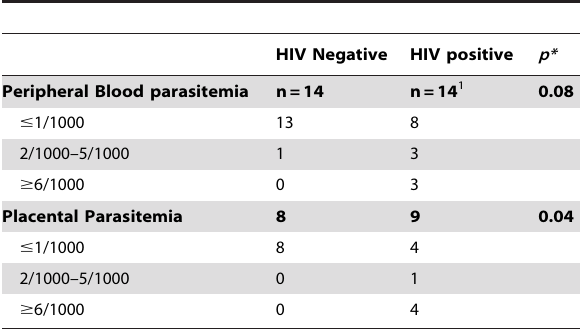
Table 2. P. falciparum parasitemia among HIV-1 negative and positive pregnant women in Yaounde´.